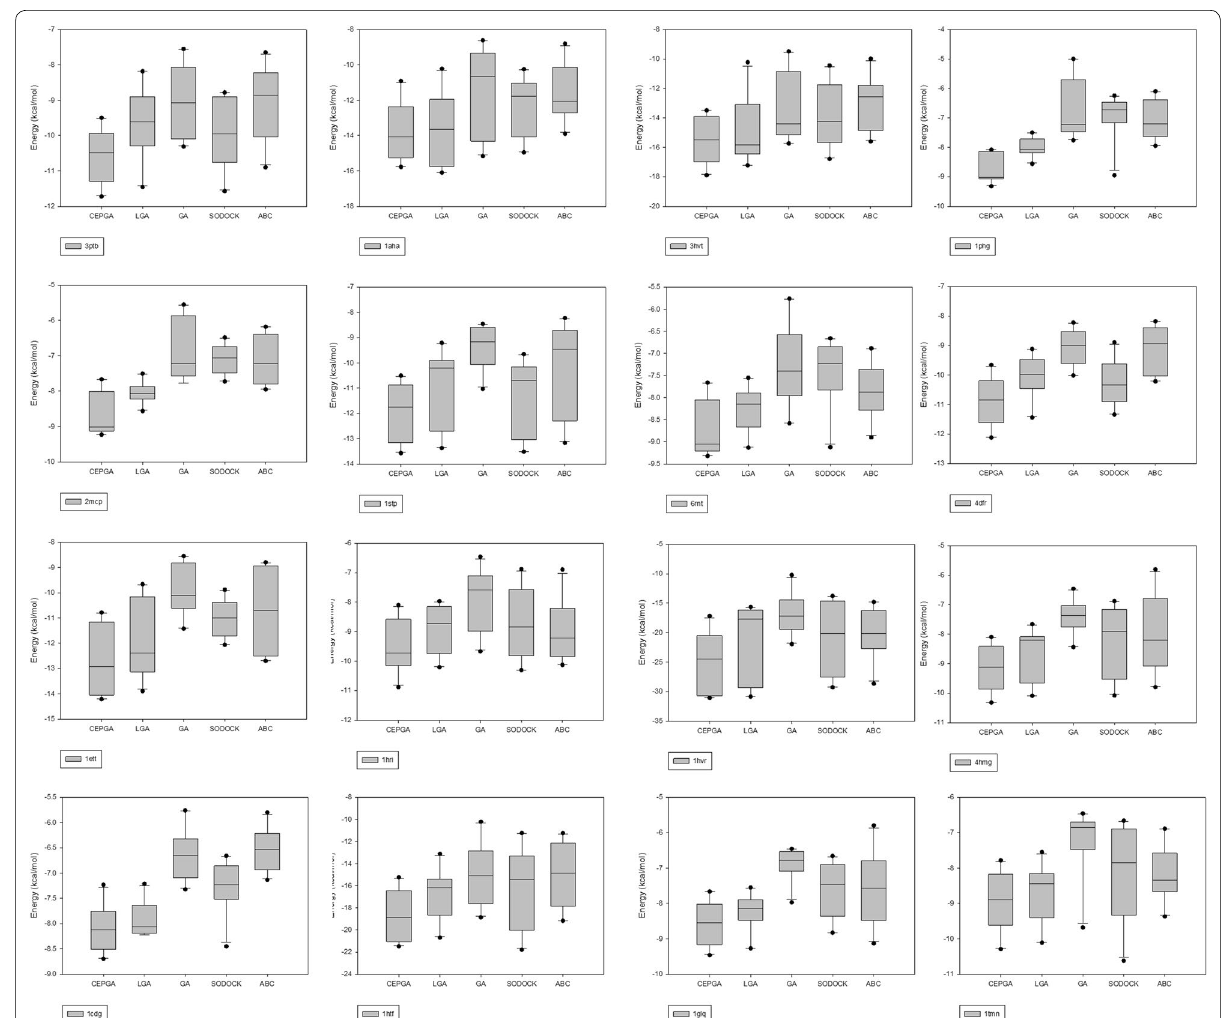
Fig. 4 Box plots of five algorithms in different PDB. The energy is used as the vertical axis and the five compared algorithms are used as the hori- zontal axis. The energy values of the upper edge, the upper quartile, the median, median, the lower four quantile, and the lower edge are recorded,